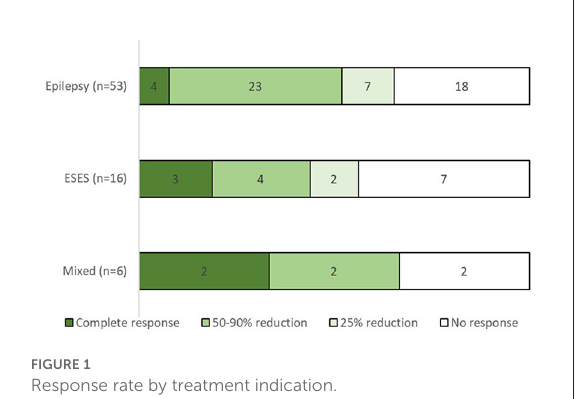
FIGURE1 Response rate by treatment